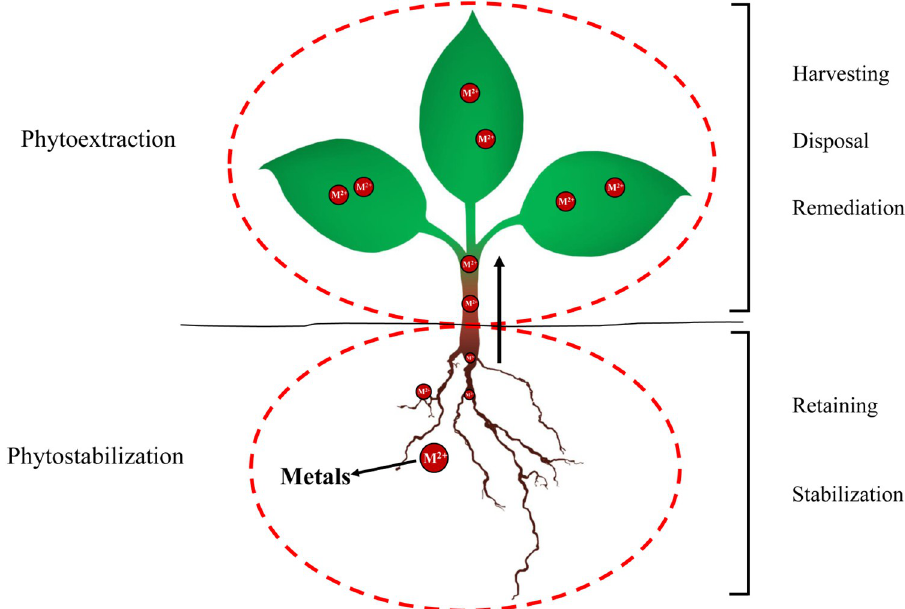
Fig 6. Phytoextraction and